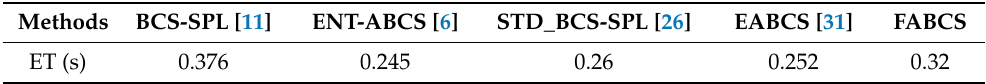
Table 4. Comparison of the ET of different methods in